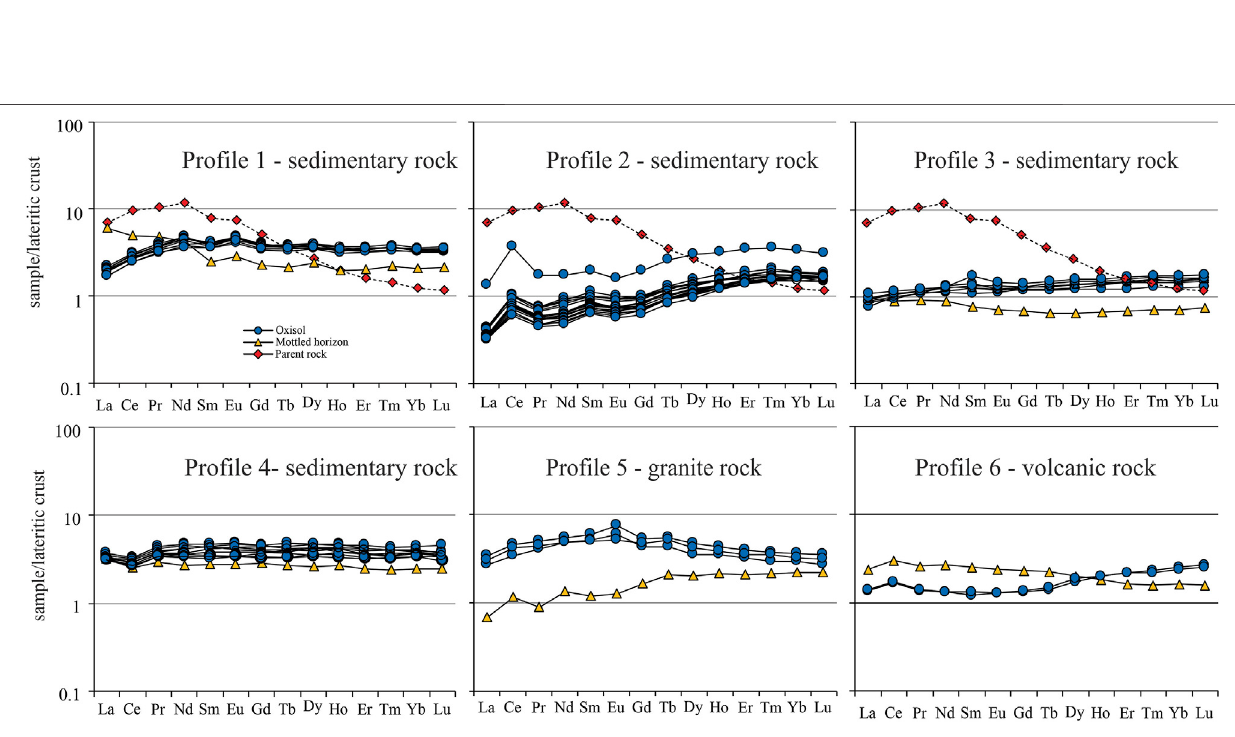
Frontiers in Earth Science |